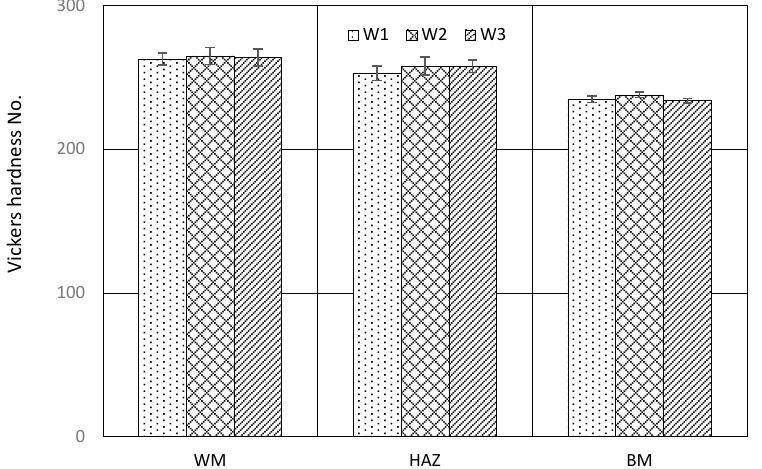
Figure 3. Hardness in different regions. Error bars indicate standard deviation.